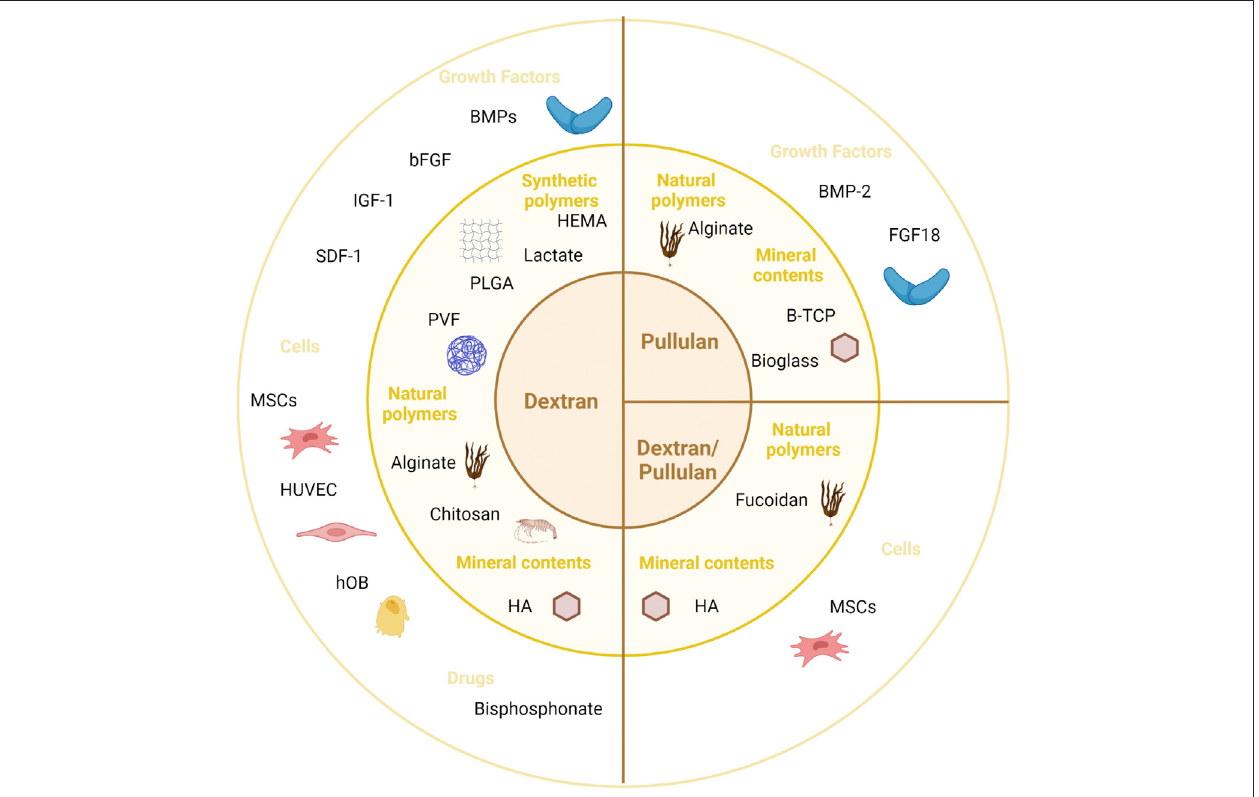
FIGURE 5 | Dextran and/or pullulan-based scaffolds for bone tissue engineering applications. Created with BioRender.com. bFGF, basic fi broblast growth factor; BMP, bone morphogenetic protein; B-TCP, beta-tricalcium phosphate; FGF, fi broblast growth factor; HA, hydroxyapatite; HEMA, hydroxyethyl methacrylate; hOB, human osteoblast; HRP, horseradish peroxidase; HUVEC, human umbilical vein endothelial cells; IGF, insulin-like growth factor; MSCs, mesenchymal stromal cells; PLGA, poly-(L-glutamic acid); PVF, polyvinyl formal; SDF, stromal-derived growth factor.